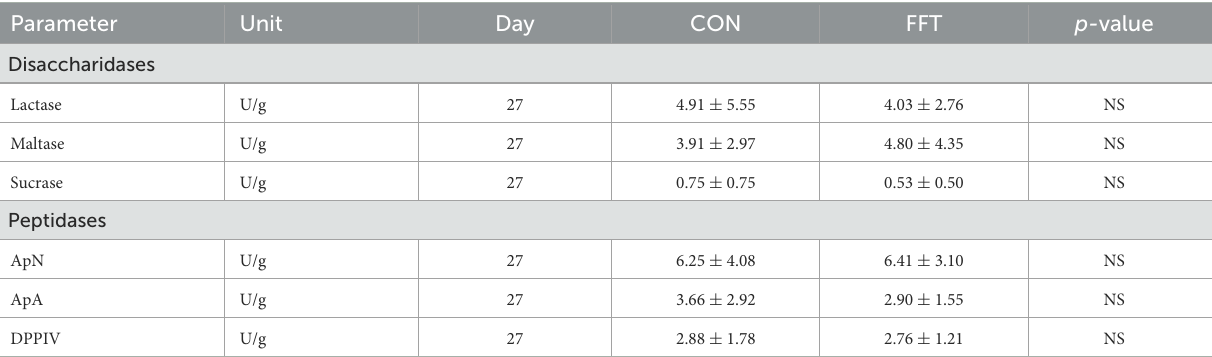
TABLE 10 Gut brush border enzymes of piglets on day 27 ( n = CON: 6; FFT: 7).